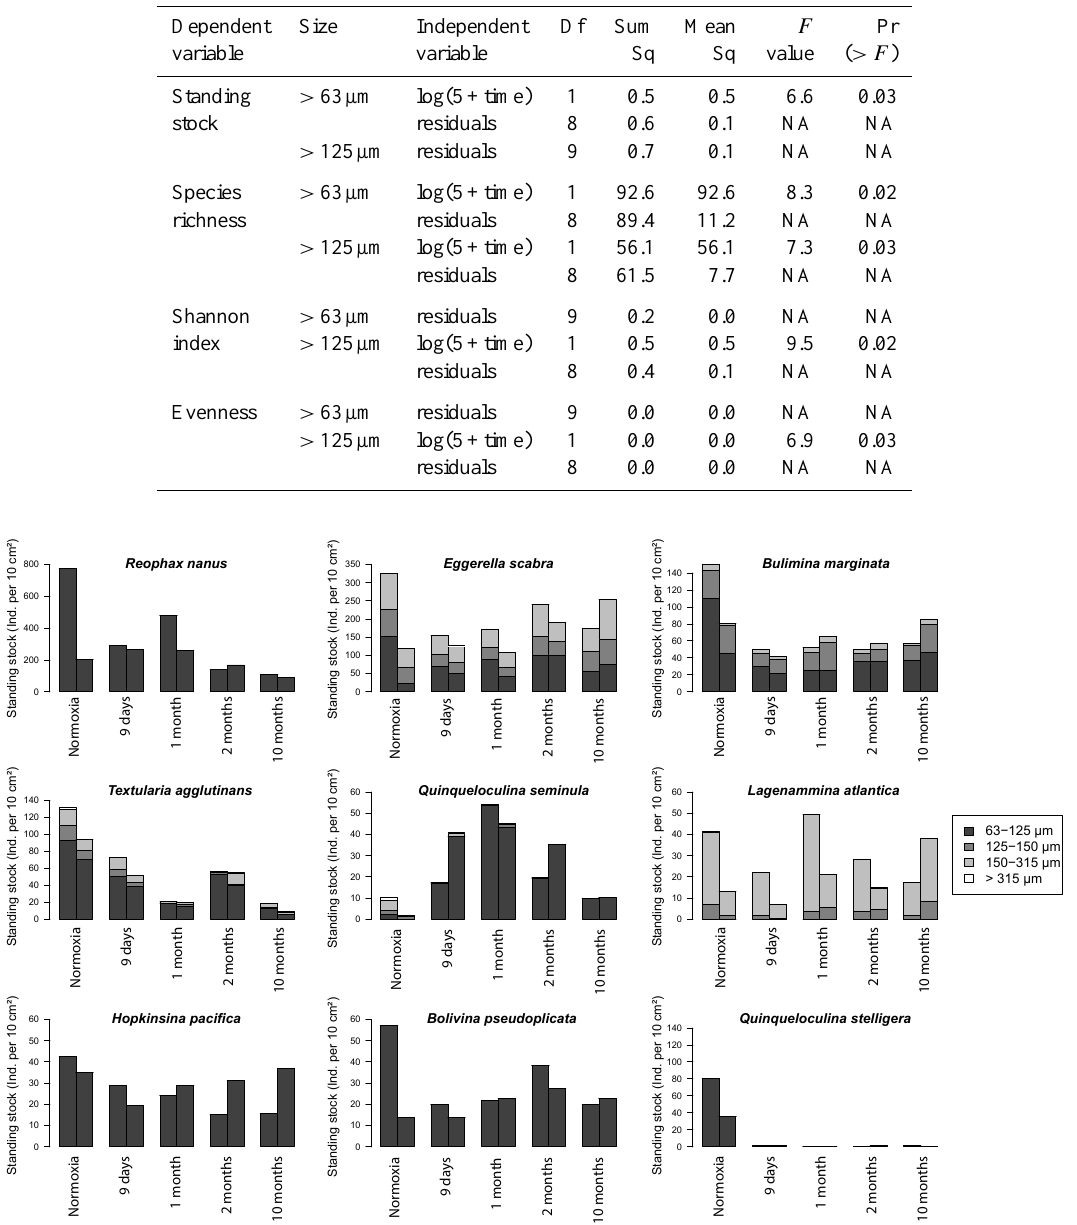
Table 3. Statistical parameters (Df: degrees of freedom; Sum Sq: sum of squares; Mean Sq: mean of squares; F value: value of the F test; Pr ( >F ): probability of the F test) for the model-type 1 at all sampled size fractions and Depth intervals for the four tested dependent variables. For the cases where no significant effect of either the time or time 2 was observed, only the “residuals” parameters are estimated.